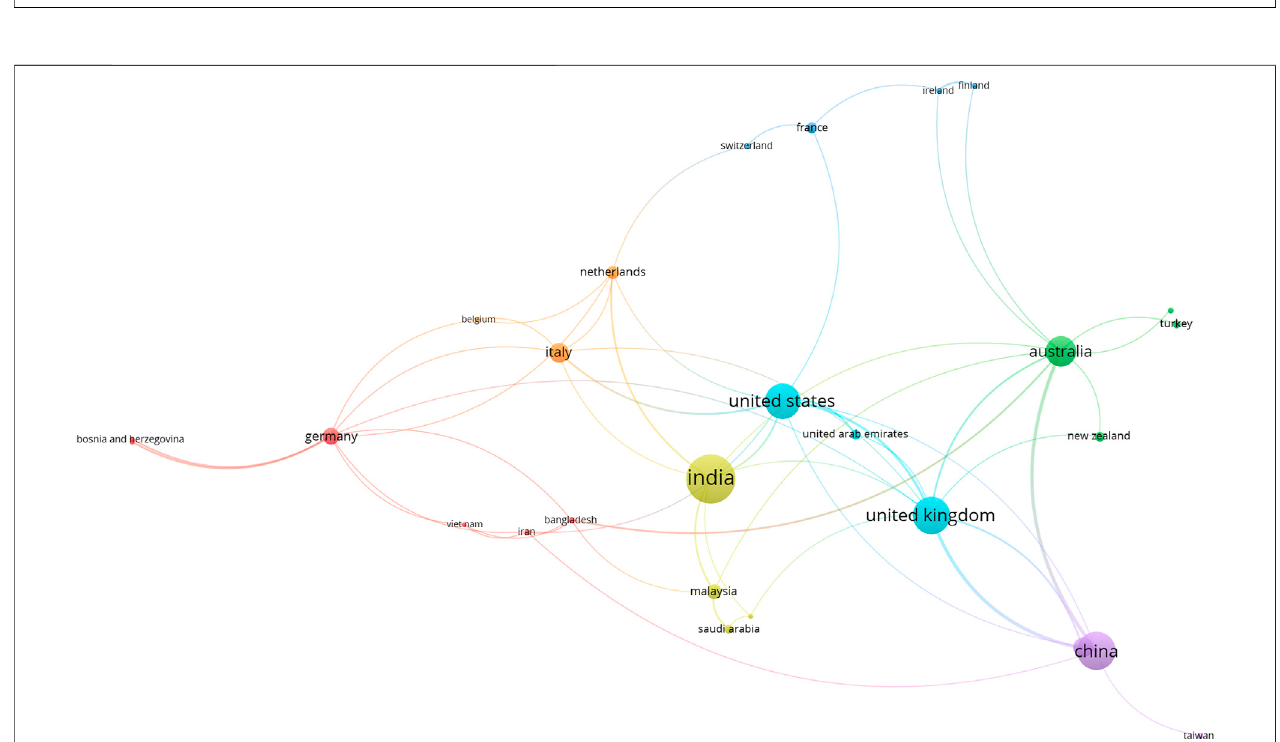
FIGURE4| Bibliometricmapoftheco-authorshipofthetopcountrieswithdocumentsincludingblockchaininthecivilengineeringandtheconstructionindustry,in Scopus.